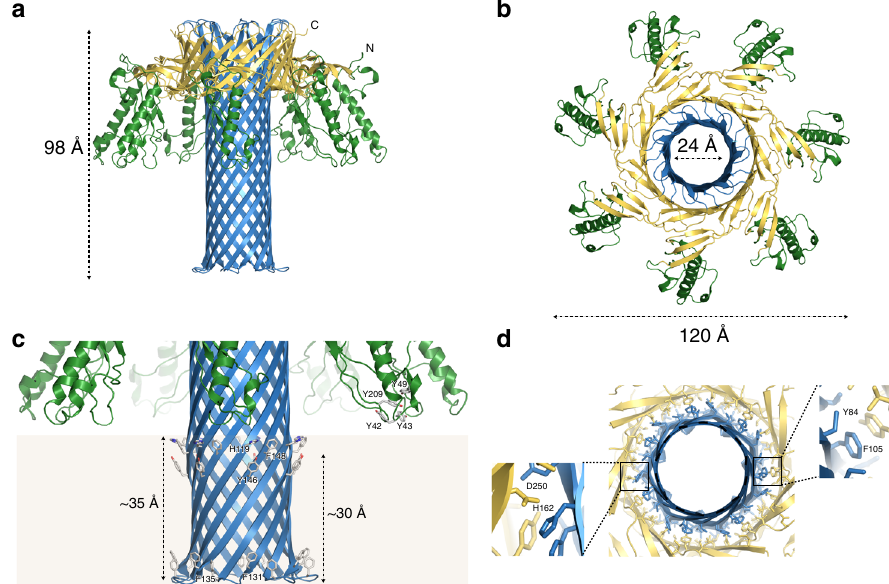
Fig. 3 Atomic model of the epsilon toxin (Etx) pore. Cartoon representation of the heptameric Etx model with height, width and lumen dimensions indicated ( a , b ). The monomers are coloured by domain: green — receptor-binding domain (RBD); blue — β -hairpin domain; yellow — cap domain. c Close-up view of the inner β -barrel and membrane-spanning region. Residues identi fi ed in previous studies as important to receptor binding in the RBD, as well as residues forming the aromatic belts, are highlighted in stick representation. The approximate boundaries of the lipid bilayer are coloured light brown. d Close-up view of the double β -barrel (DBB) fold viewed from the membrane side with interacting residues shown in stick